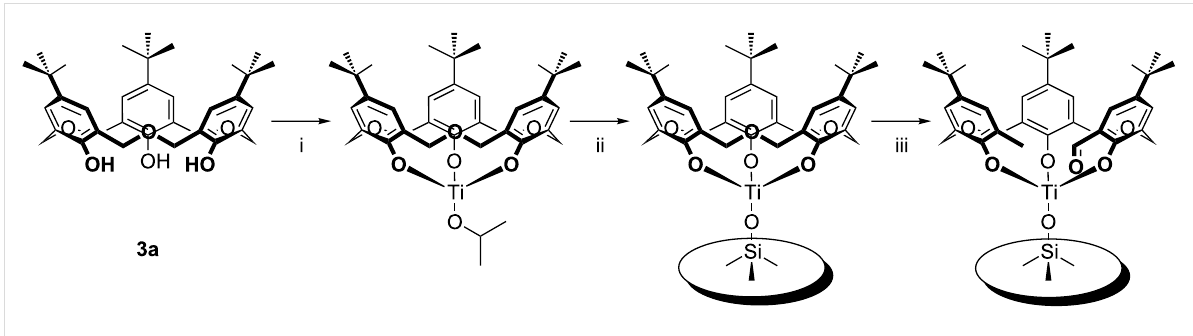
Klufers prepared complexes of 3b , 3d and 3k through reaction of the macrocycles with (Et 3 N) 2 [Re(CO) 3 Br 3 ] in acetonitrile